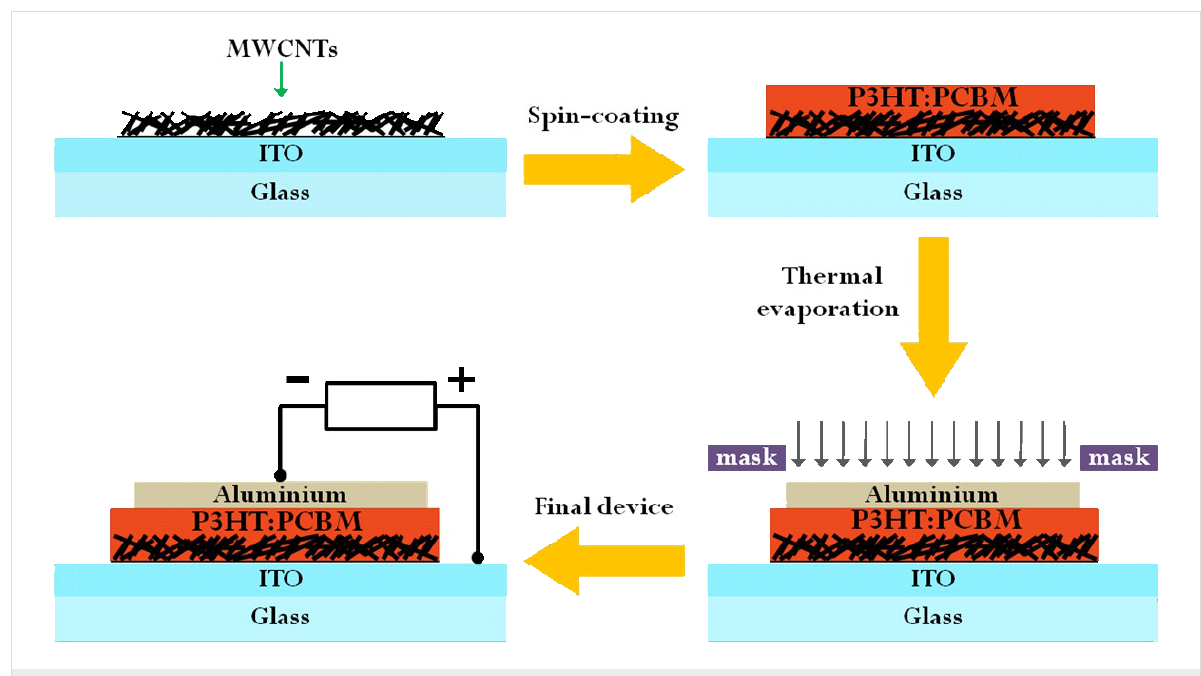
Figure 7: Schematics of the preparation of a P3HT:PCBM solar cell with CNT-enhanced